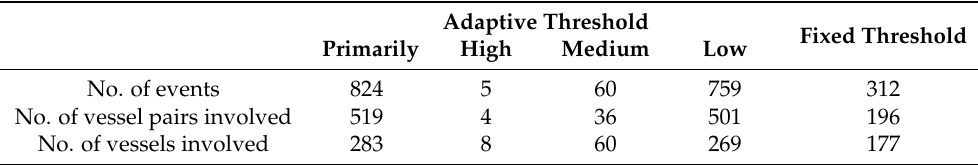
Table 14. Identification results in the sea area with dense